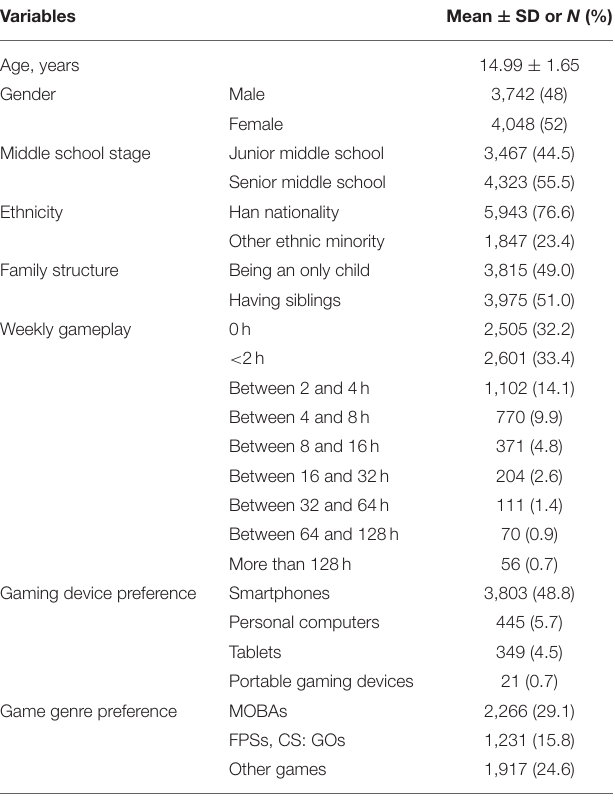
TABLE 2 | Socio-demographic and gameplay characteristics of the sample ( N = 7,790).